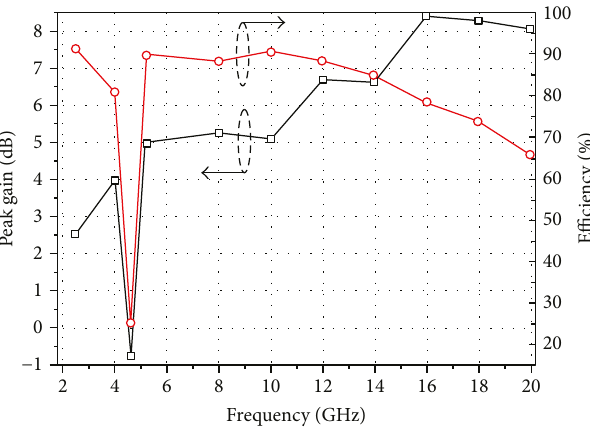
Figure 9: Measured gain and e ffi ciency of the proposed antenna.